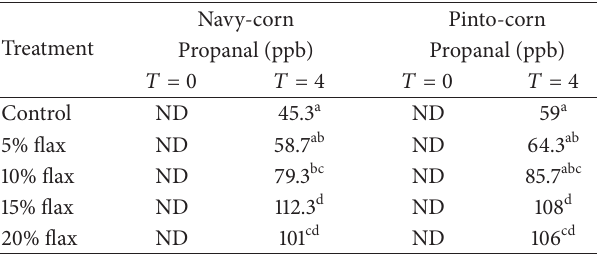
Table 6: Propanal values of navy-corn and pinto-corn extrudates at different time